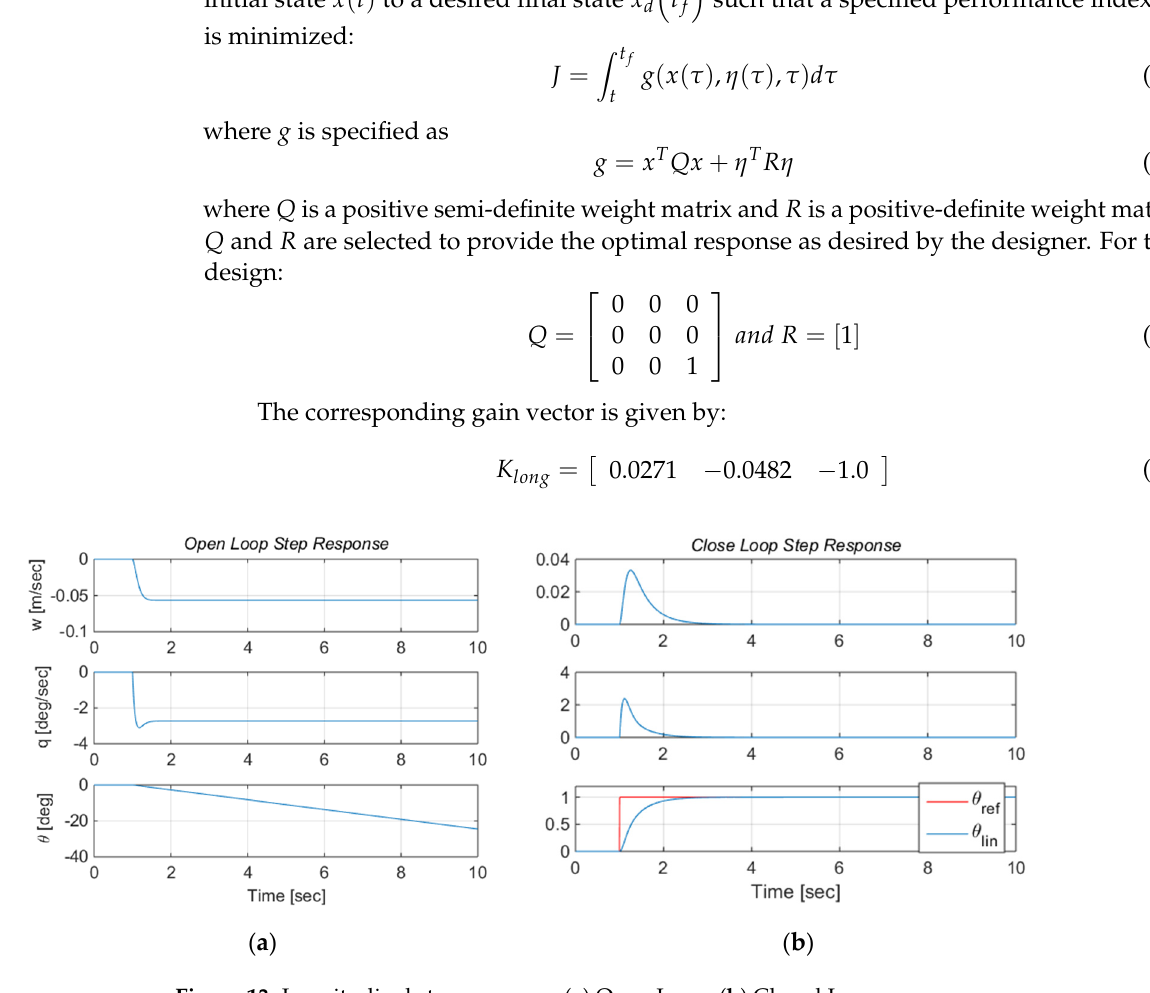
Figure 13. Longitudinal step response: ( a ) Open Loop, ( b ) Closed Loop. The feedback response for the attitude-hold control system in response to a 1 ◦ step input is shown in Figure 13b. The rise and settling time of the pitch angle are 0.784